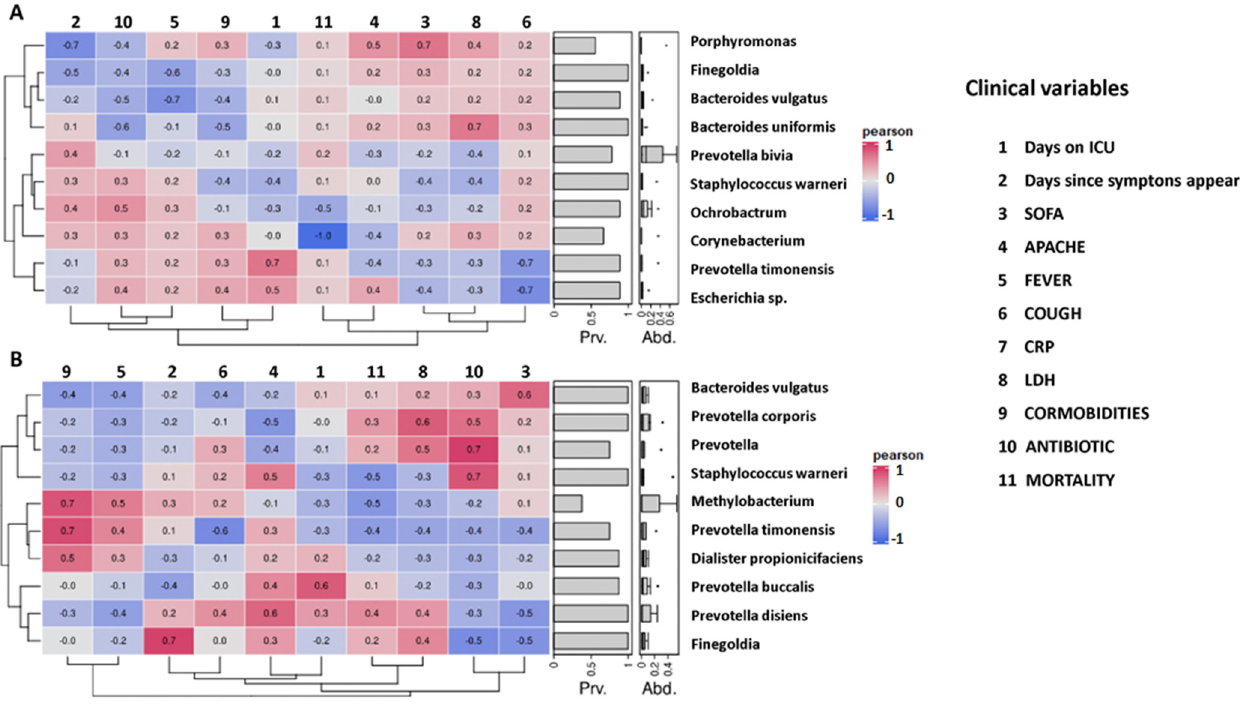
Figure 4. Correlation between gut microbiota of non-colonized and colonized SARS-CoV-2 patients and their clinical variables at the time of entering ICU facilities. ( A ) Correlation plot for non-colonized group. ( B ) Correlation plot for colonized group. The plot only takes into account the most abundant taxa with a prevalence of 90%. Pearson correlation coefficient was calculated for both groups.